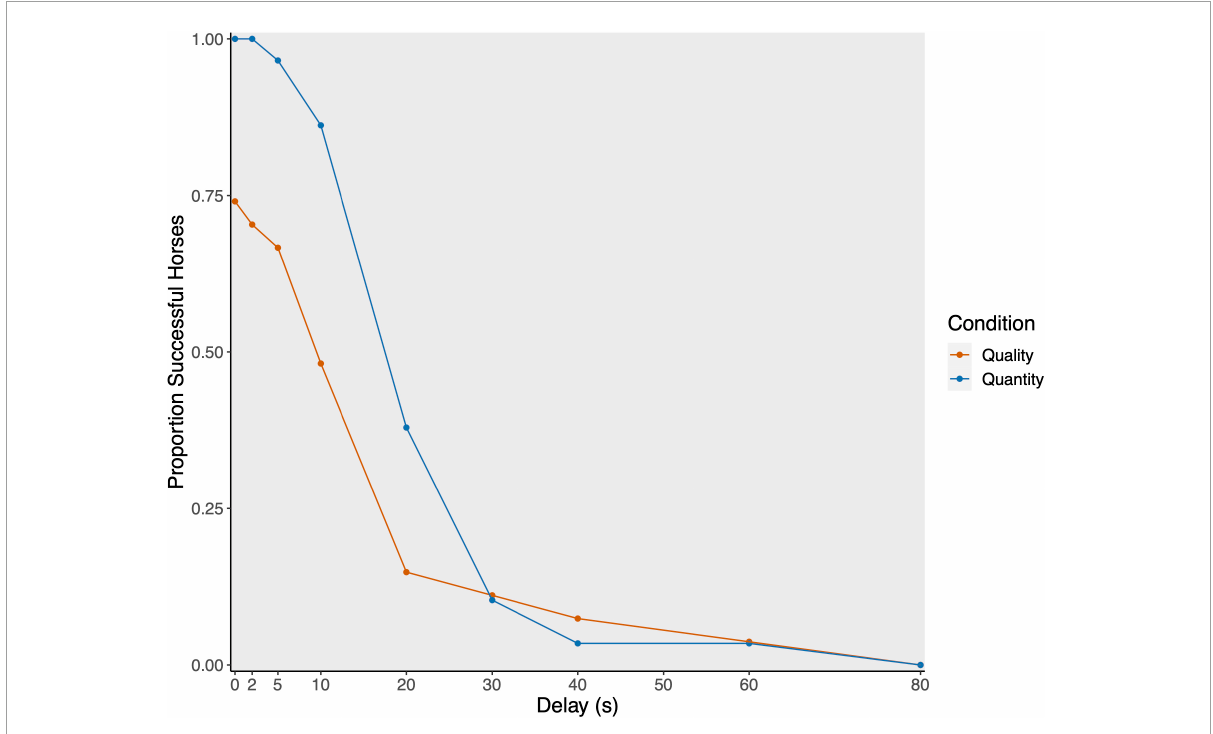
FIGURE3 Proportion of successful horses per delay stage plotted separately for quality (red; N = 28) and quantity condition (blue; N = 29).